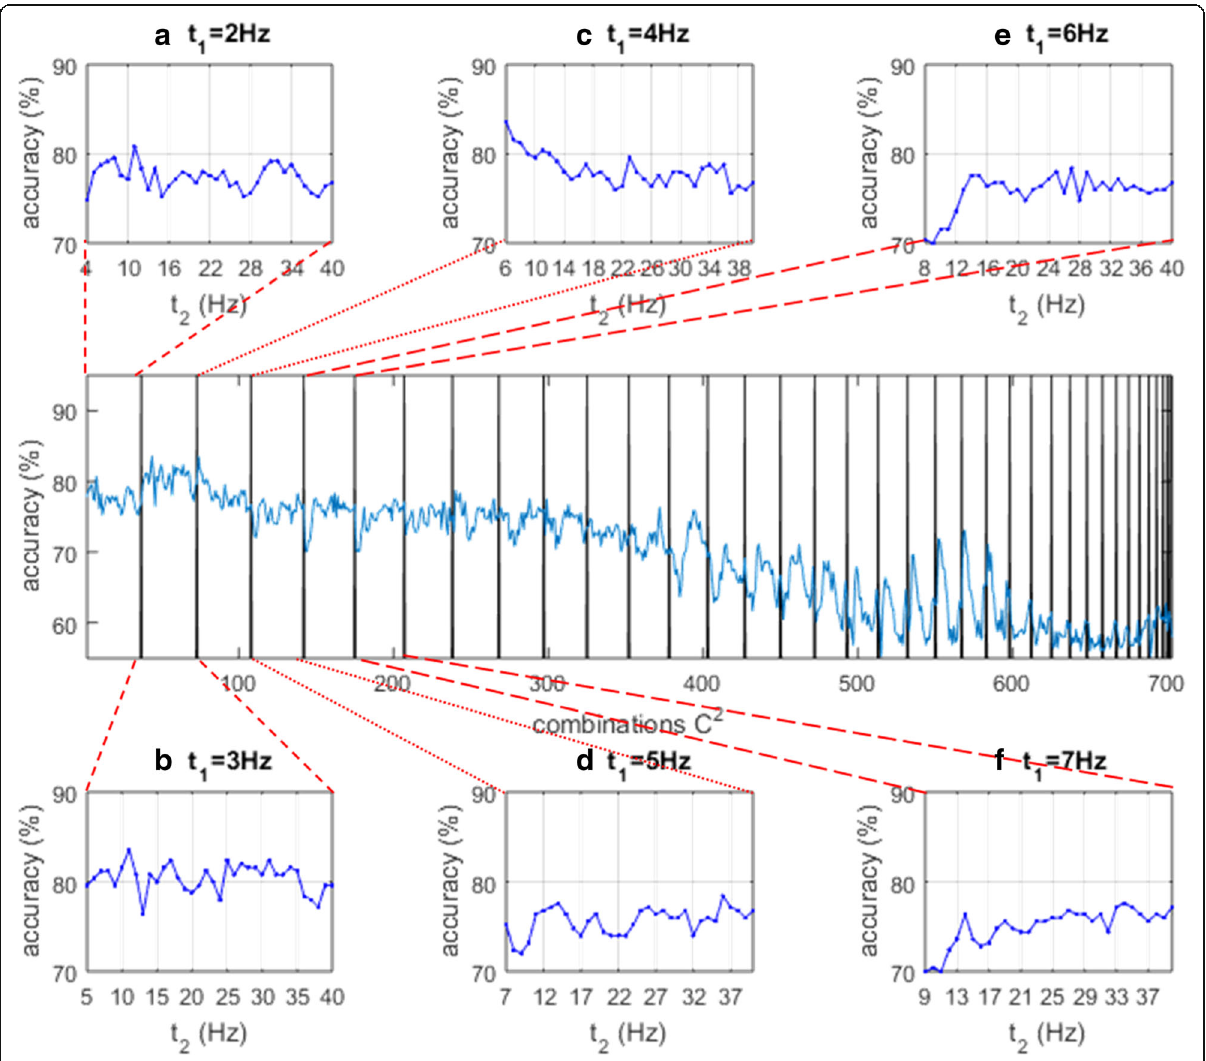
Fig. 9 Accuracy results (%) for N = 2. Results for a t 1 = 2 Hz and t 2 = 4:40 Hz, b t 1 = 3 Hz and t 2 = 5:40 Hz, c t 1 = 4 Hz and t 2 = 6:40 Hz, d t 1 = 5 Hz and t 2 = 7:40 Hz, e t 1 = 6 Hz and t 2 = 8:40 Hz, f t 1 = 7 Hz and t 2 = 9:40